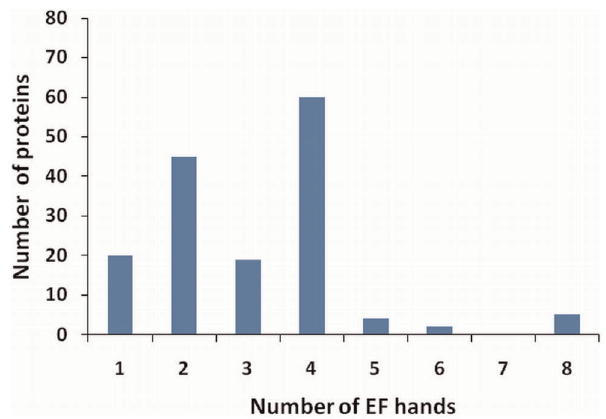
Figure 3. Occurrence of EF-hands. The number of Caenorhabditis proteins having 1, 2, 3, 4, 5, 6 or 8 EF-hands.